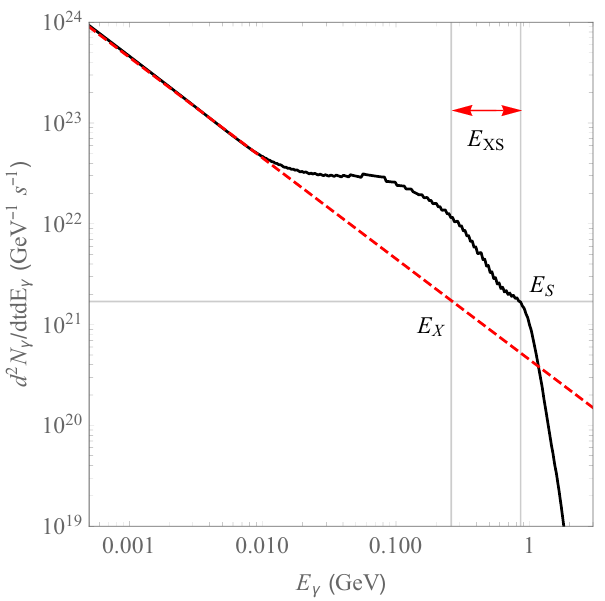
Figure 5 . Photon spectrum near the primary emission peak for a PBH with M = 7 . 5 × 10 10 kg and ˜ a = 0 , illustrating the “shoulder” feature, the pion “bump” and the fit to the low-energy tail of the secondary spectrum (dashed red